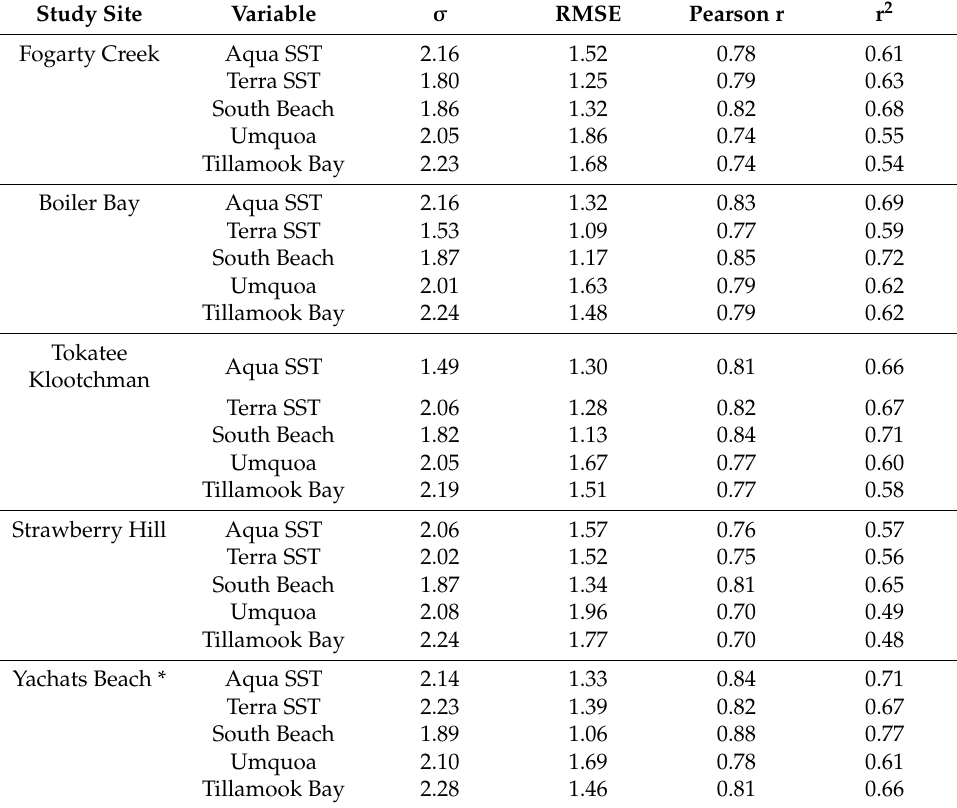
Table 4. Standard deviation ( σ ), root mean square error (RMSE), Pearson r correlation coefficient, and r-squared (r 2 ) are shown for each linear model used to predict submerged mussel logger temperature at each study site. The Taylor Diagram and correlation matrix output for every study site is shown in the